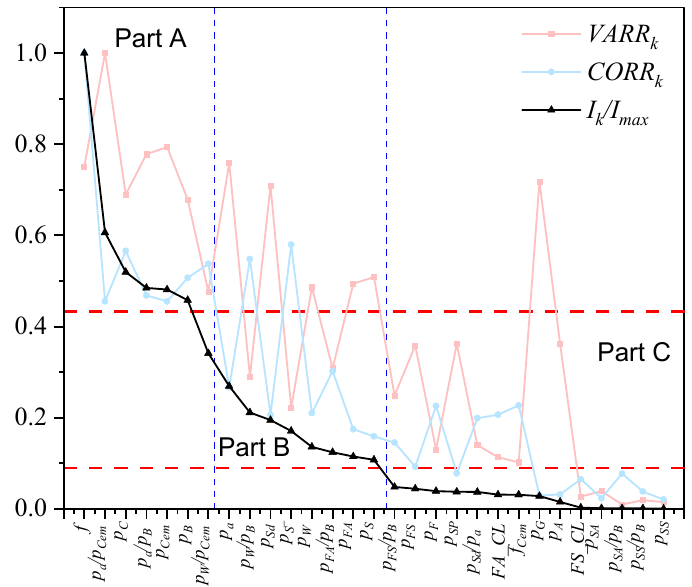
Figure 3. Analysis results of each factor.